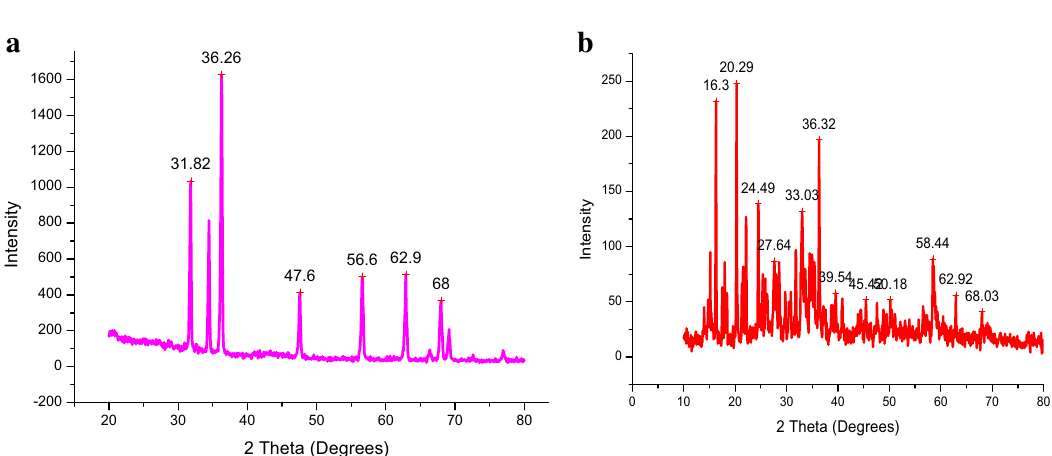
Figure 9. ( a) XRD image of carbon spher before loading Zn. ( b ) XRD image of carbon spher after loading Zn.